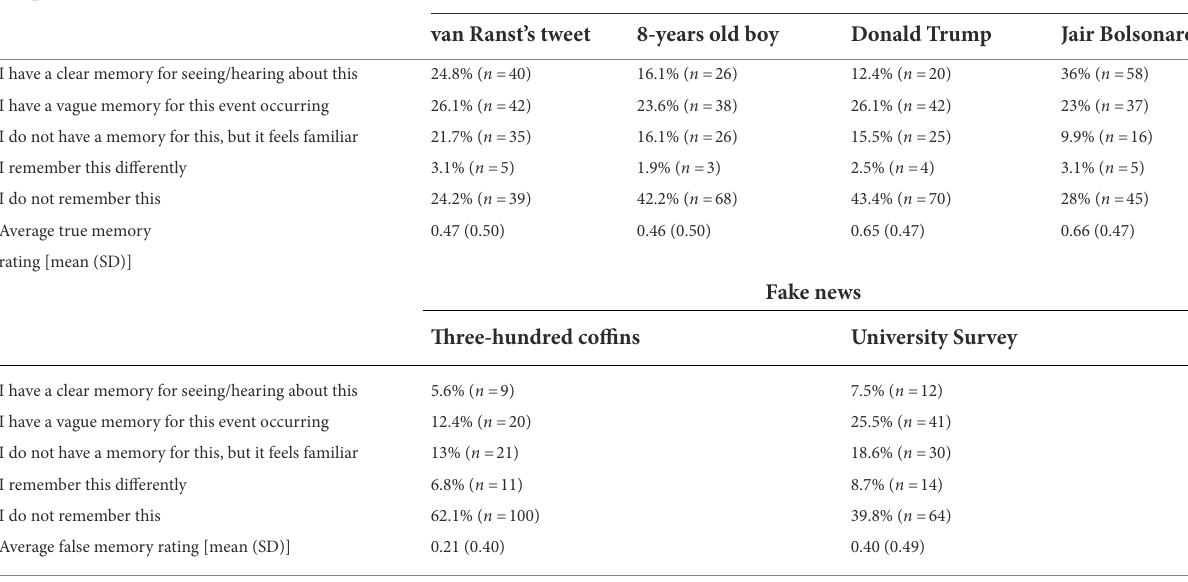
TABLE 1 Participants’ responses to true and fake news (Experiment